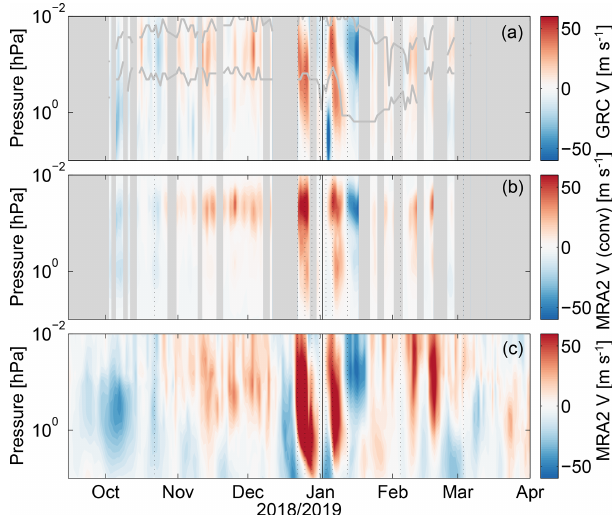
Figure 3. Same as in Fig. 2 but for meridional